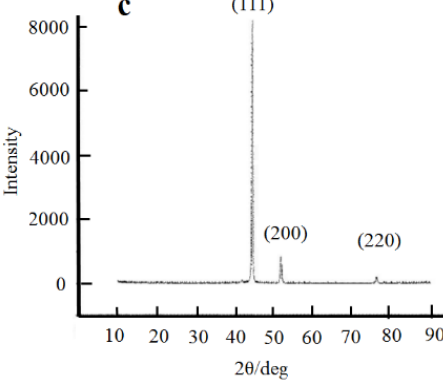
Figure 13. Tests on the properties of nickel plating prepared under the optimum process parameters scheme. ( a ) Load- displacement curve, ( b ) Ra, ( c ) X-diffraction pattern.